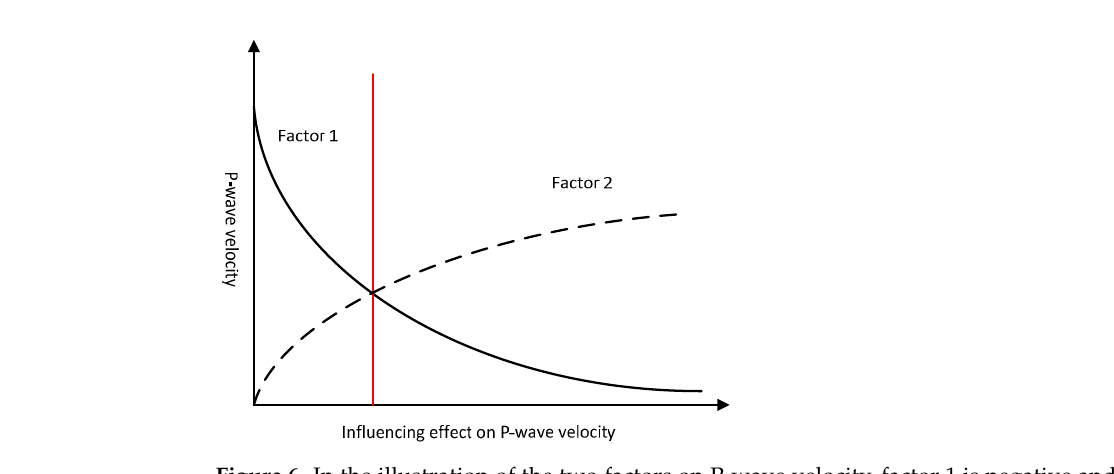
Figure 6. In the illustration of the two factors on P-wave velocity, factor 1 is negative and factor 2 is positive.